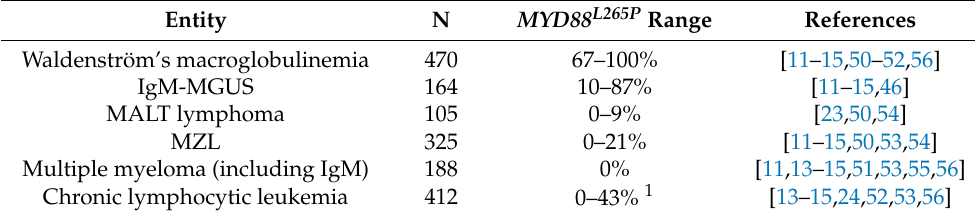
Table 1. The frequency of MYD88 L265P in B-cell lymphoproliferative disorders. Entity N MYD88 L265P